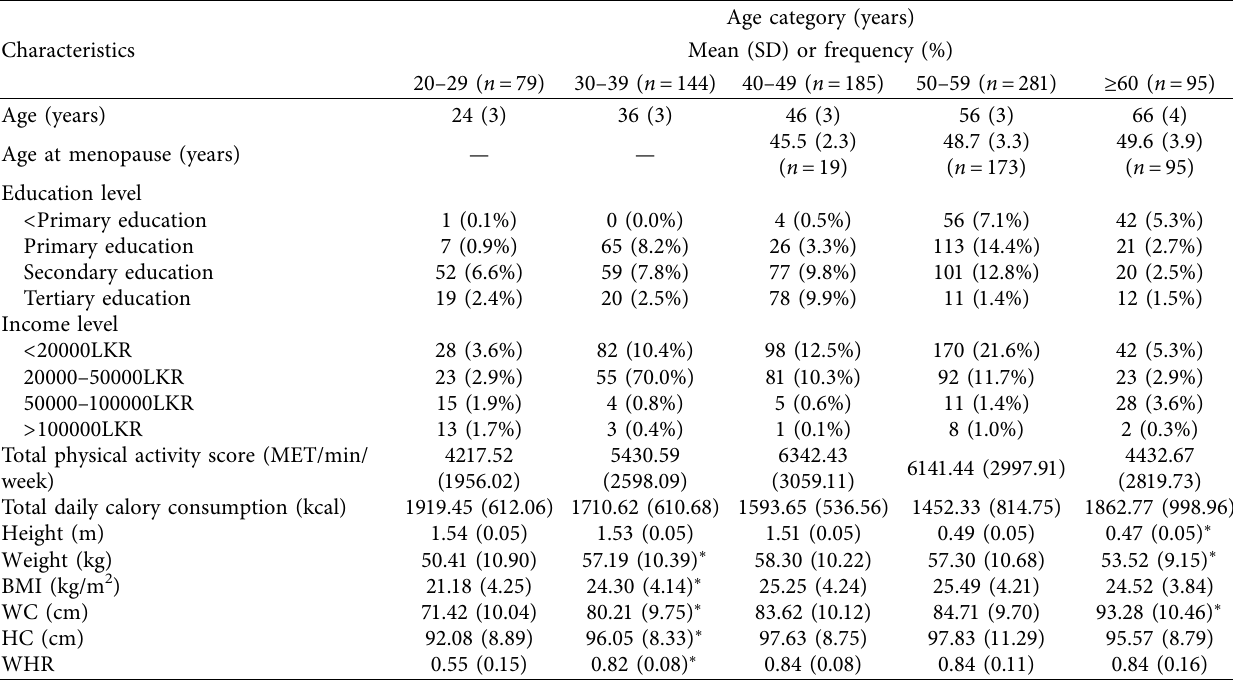
Table 1: Basic characteristics of the participants.